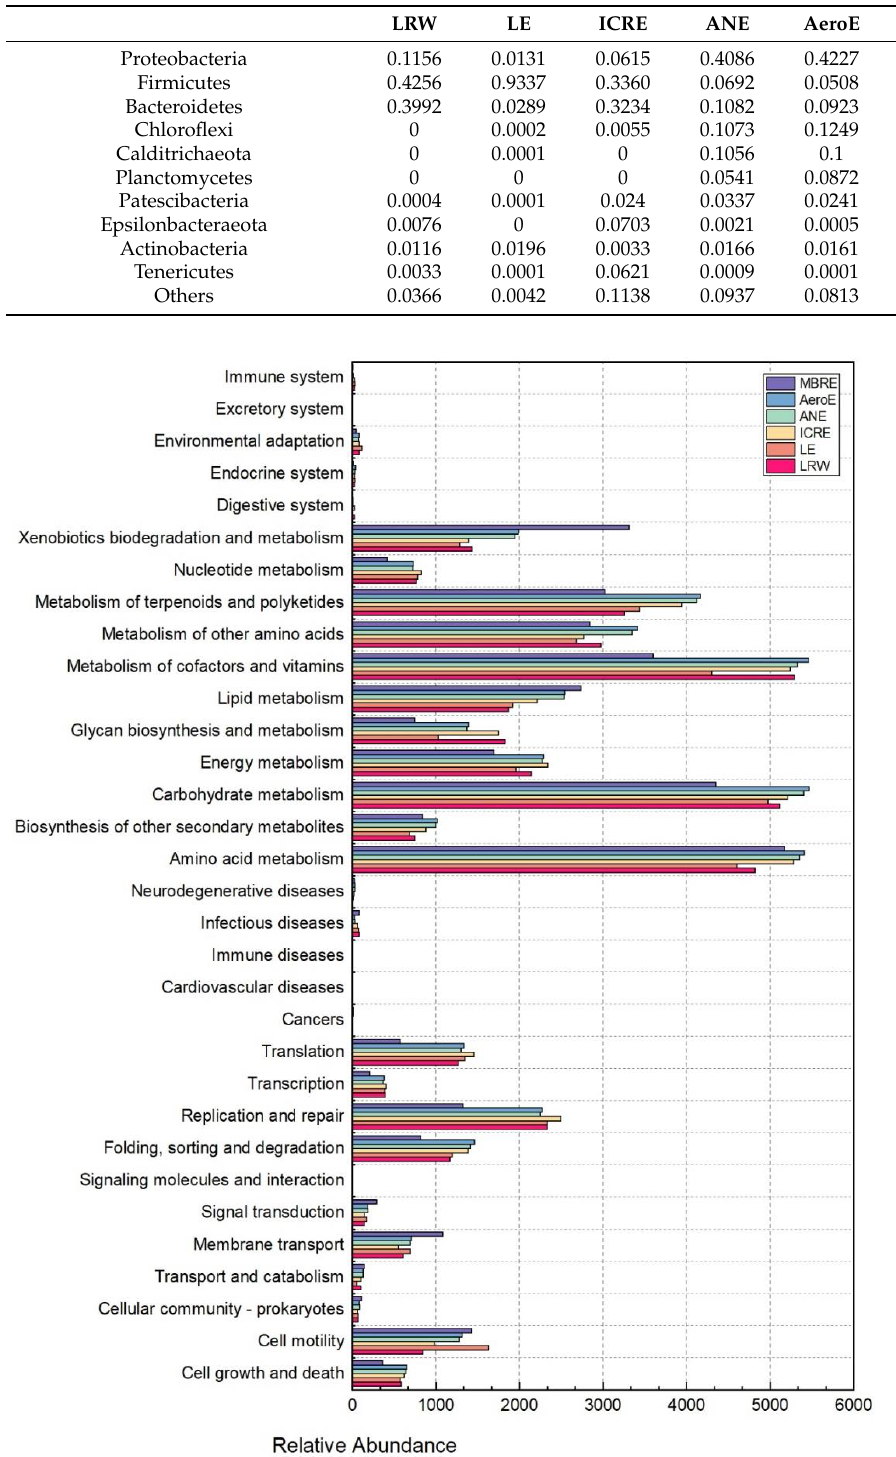
Figure 6. Prediction of community functional potential (percentage per million functional units) for six leachate samples (LRW, LE, ICRE, ANE, AeroE, and MBRE) based on the KEGG